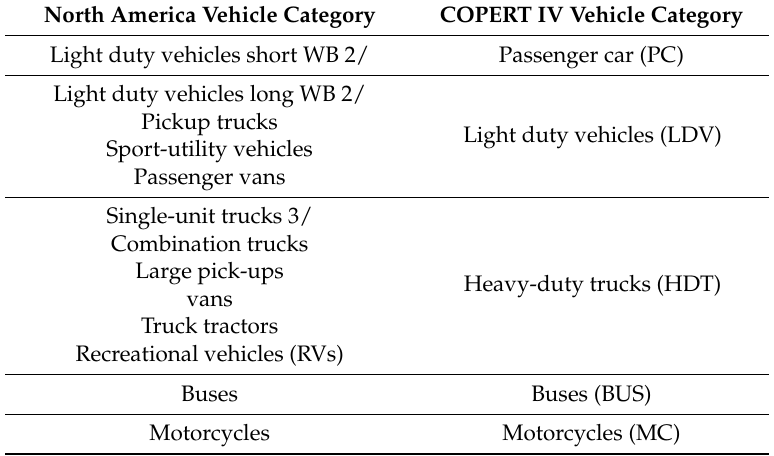
Table 3. Vehicle categories used in North America and the corresponding categories in the COPERT IV